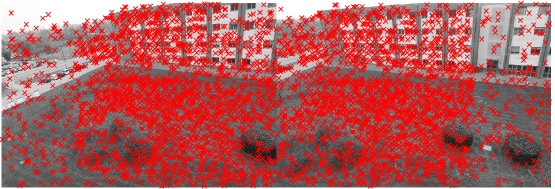
Figure 2. Feature matching based on the descriptors (appearance- based).